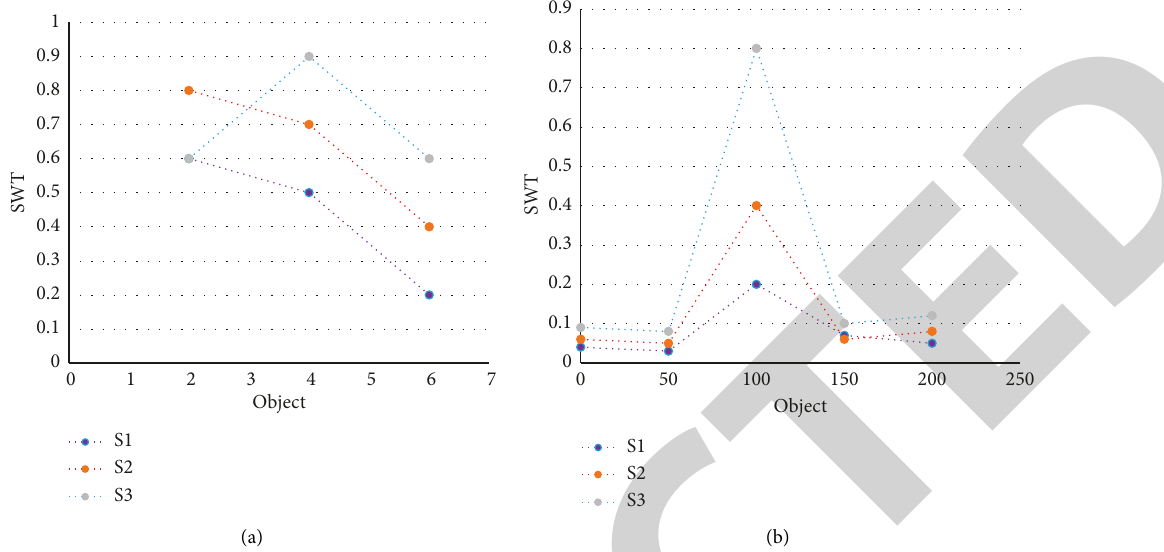
Figure 8: Strain Energy Density SWT Values: (a) distribution of SWT along the contact path and (b) SWT distributed along the angle.